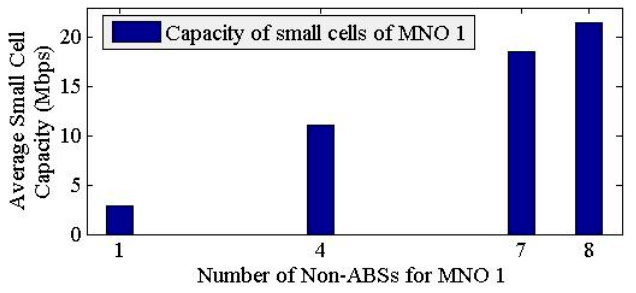
Figure 6. Capacity performance of small cells of MNO 1 with the variation of